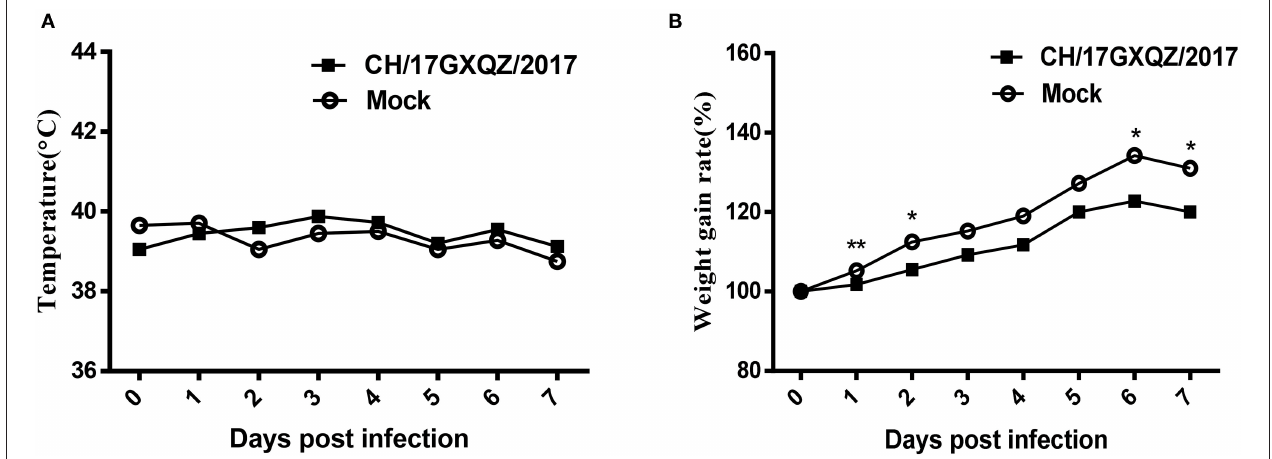
FIGURE 6 | Trends of rectal temperatures and weight gain of 7-day-old piglets inoculated with EV-G. Normal rectal temperatures were present in both the infected and mock groups (A) . The weight gain rates of piglets were analyzed, those in the infected group was significant less than in pigs from the mock group at 1, 2, 6, and 7 dpi. Each point on the graph represents the average values from the four pigs. * and ** indicate P < 0.05 and P < 0.01, respectively, between the two groups (B) .